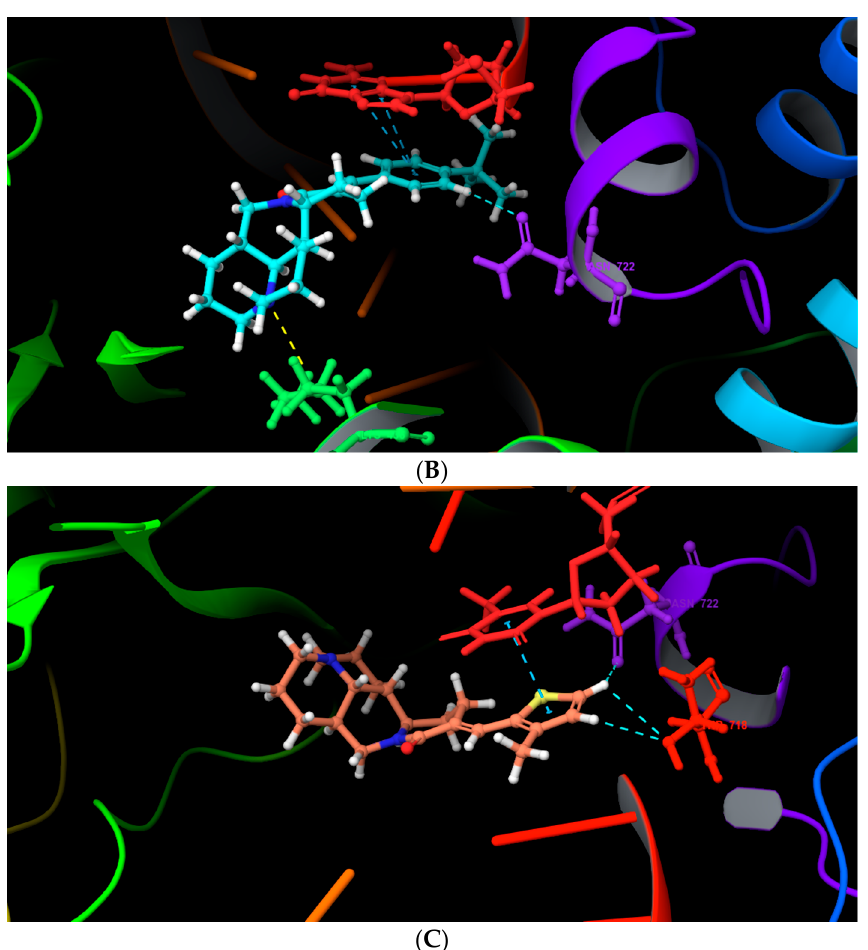
Figure 3. Molecular docking models of sophoridine ( A ); 2e ( B ); 2k ( C ) in the active site of DNA–Topo I complex (PDB ID: 1T8I).